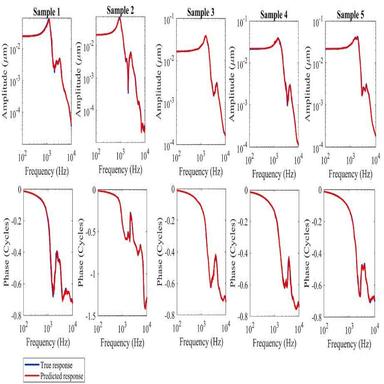
Results of predictions of created ML models for the amplitude and phase of umbo. Results of five random samples from the testing dataset are presented here. The ML models can fairly represent the amplitude and phase of the umbo at almost all frequencies. The difference between the predicted and true values of the displacement amplitude of the umbo in these 5 samples is less than 2 dB at more than 90% of frequencies. Also, for all samples shown in this figure, the cosine difference between the true and predi